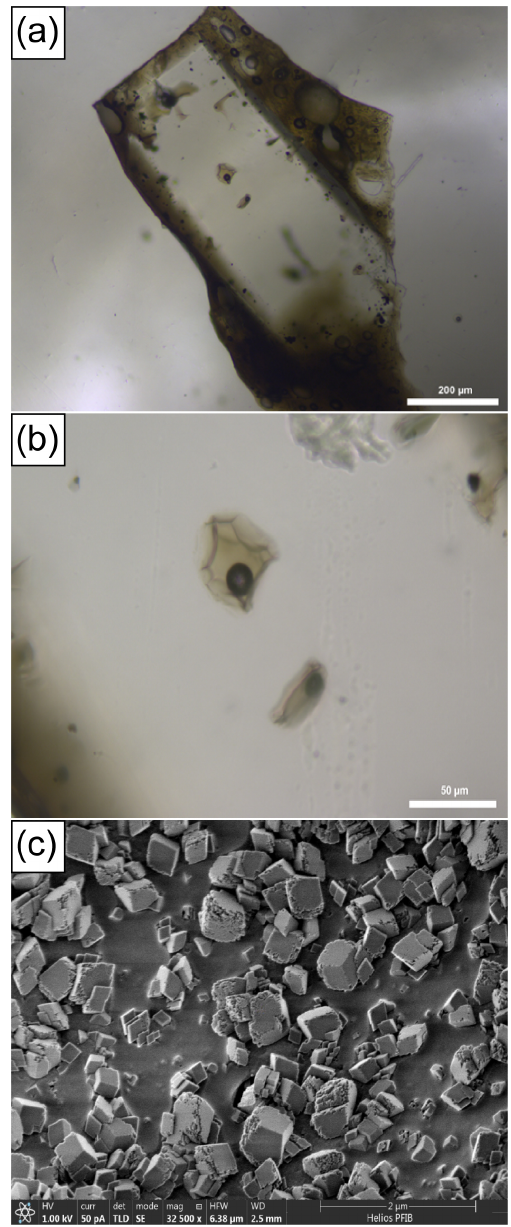
Figure 1. (a) Euhedral olivine phenocryst from Thueyts showing a large melt inclusion and a smaller one in its core and several small melt inclusions and embayments along its rims. (b) Zoom on the large melt inclusion showing the CO 2 -rich bubble and the charac- teristic shape of the Bas-Vivarais melt inclusions: the melt inclusion is an irregular polyhedron with rounded faces convex towards the interior of the inclusion. (c) Field-emission scanning electron mi- croscope (SEM) microphotograph showing rhombohedral carbon- ate microcrystals on the bubble wall of a melt inclusion from Lac d’Issarlès, Bas-Vivarais (microphotograph taken by Dr. Letian Li with a Helios G4 PFIB CXe system at the Thermo Fisher Scientific NanoPort in Eindhoven, the Netherlands). Scale bars: 200µm in (a) , 50µm in (b) , and 2µm in (c)